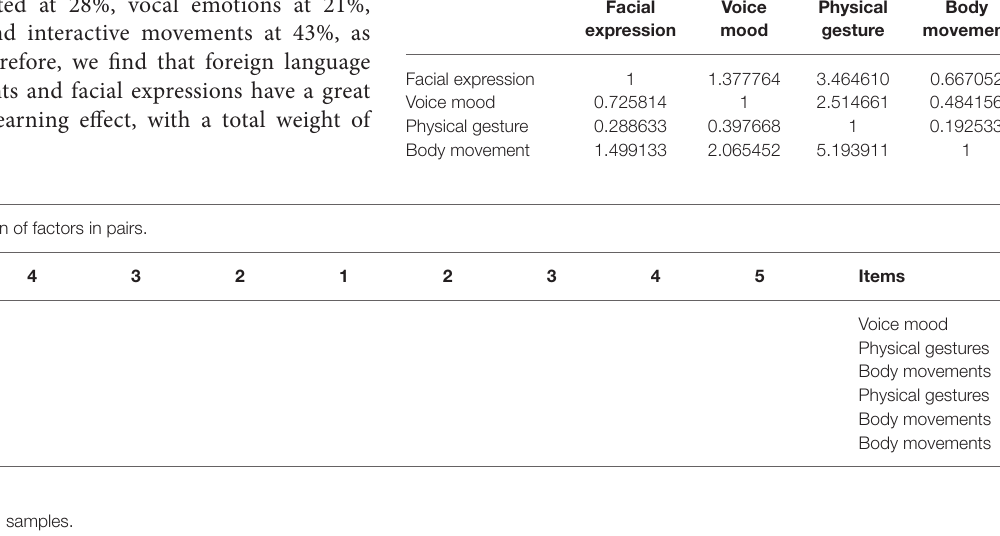
TABLE 4 | Judgment matrix table of target layer and criterion layer.